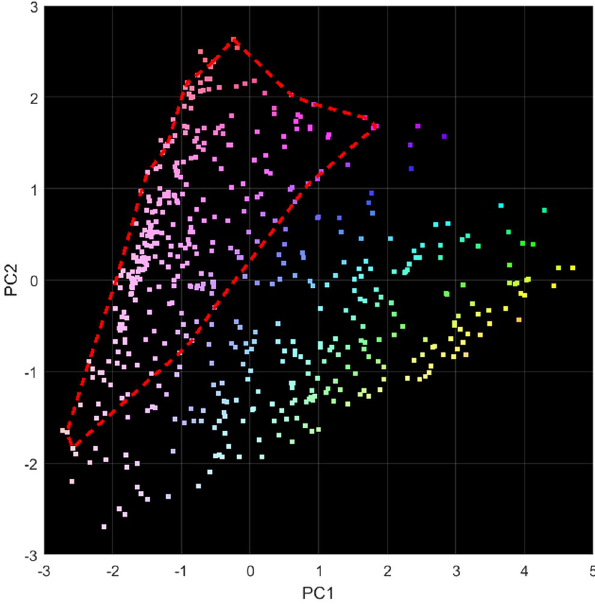
Figure 3. Principal component analysis (PCA) results based on the diffraction data (522 spectra) plotted with respect to PC1 and PC2. All positions within the samples that were identified as tumorous by histology are contained within the bounded region.